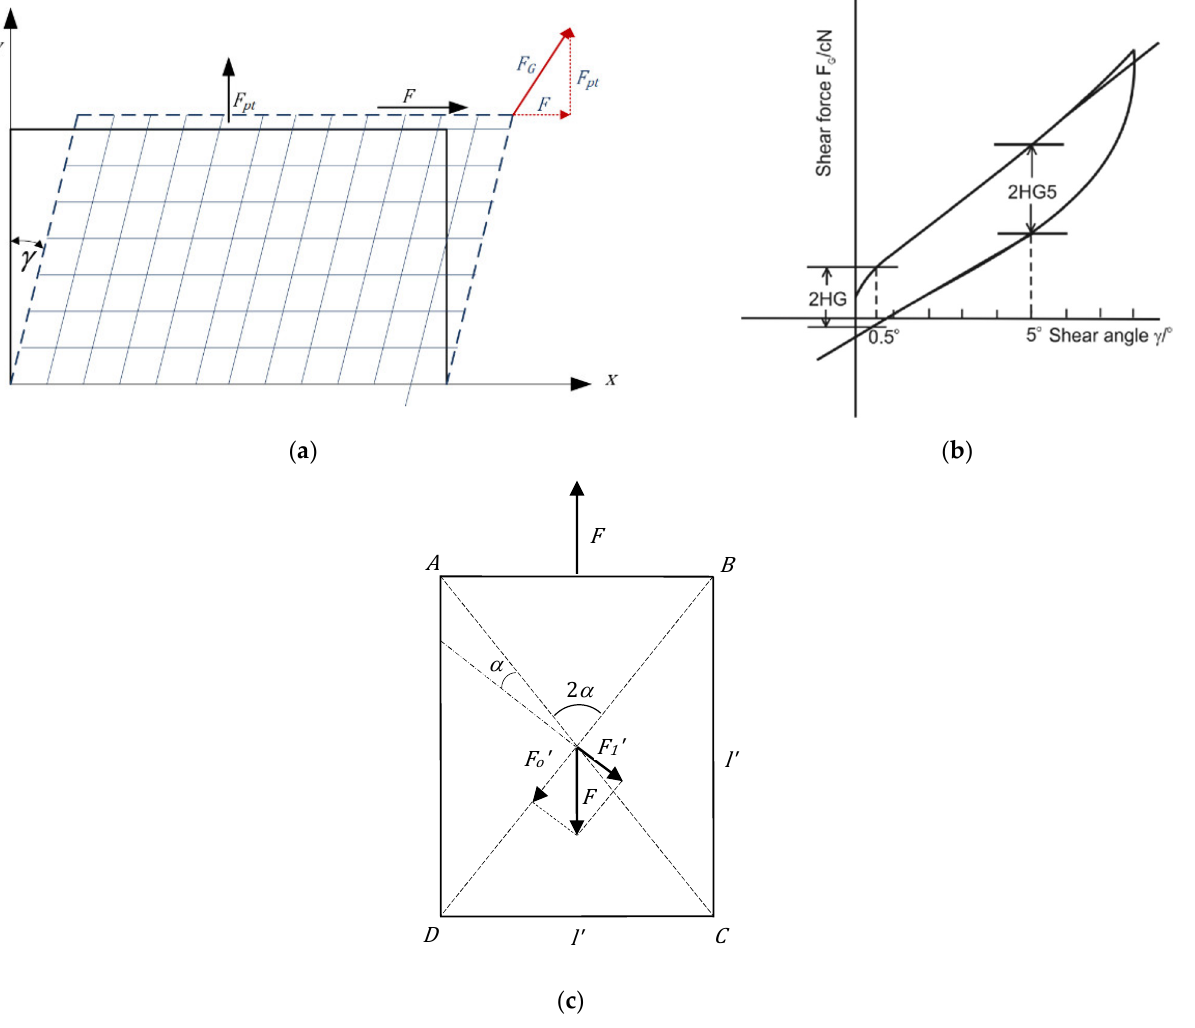
Figure 1. Principle of shear properties measurement: ( a , b ) Principles and diagram for KES and ( c ) FAST—Bias extension test.